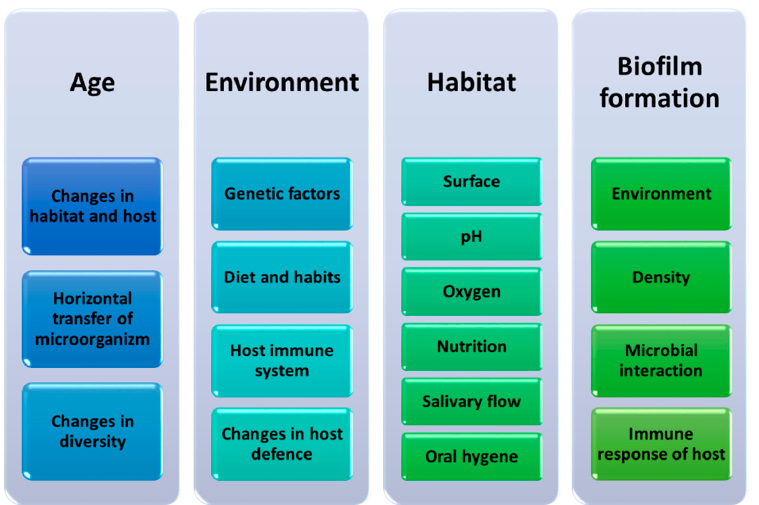
Figure 3. Factors influencing changes in the composition of the oral microbiota during human life (based on [11]).